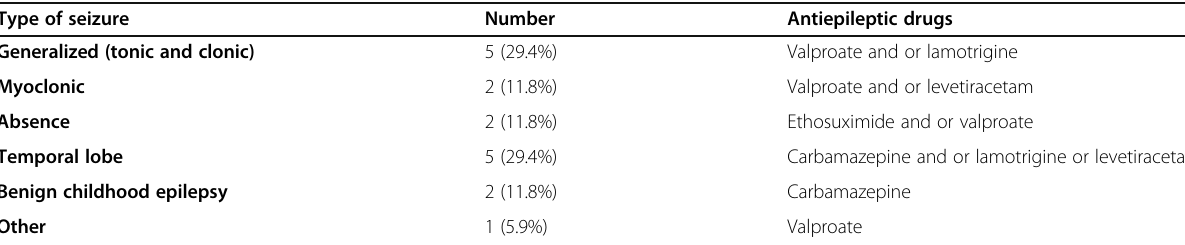
Table 2 Type of epilepsy among patients with SLI Type of seizure